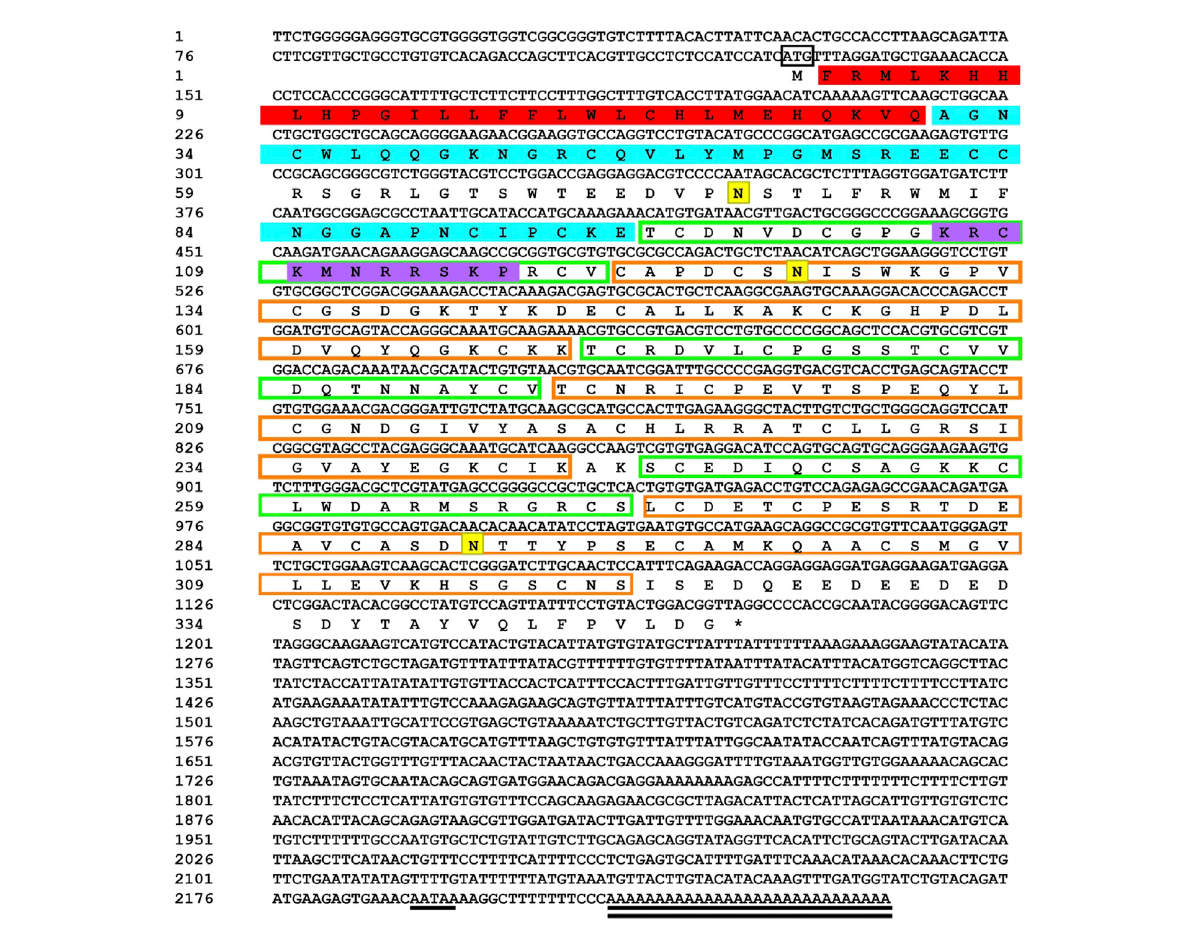
FIGURE 1 Sequencing results and amino acid sequence analysis of transcription factor FST of Odontobutis potamophila. The black box indicates the ATG start codon; * indicates the termination codon; underlines indicate the Poly(A) plus tail signal; double underlines indicate the poly(A) sequence; red shading indicates a possible signal peptide region; blue shading indicates a possible TGF β binding structural domain; green boxes indicate three possible repetitive follistatin structural domains; orange boxes indicate three duplicated Kazal structural domains; purple shading indicates possible nuclear localization signals; and yellow shading indicates possible N-glycosylation